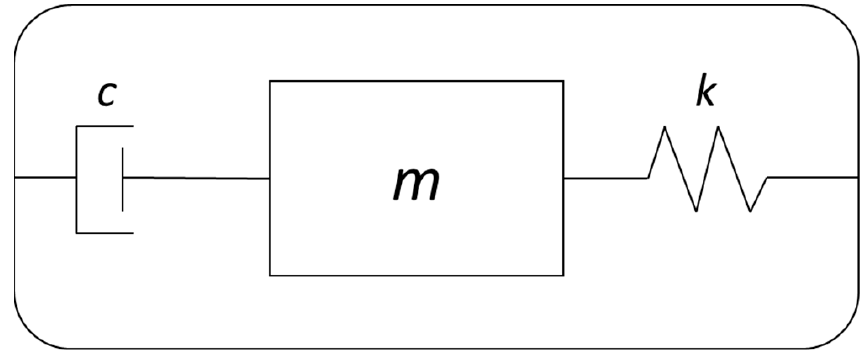
Figure 3. Typical one degree of freedom resonator.